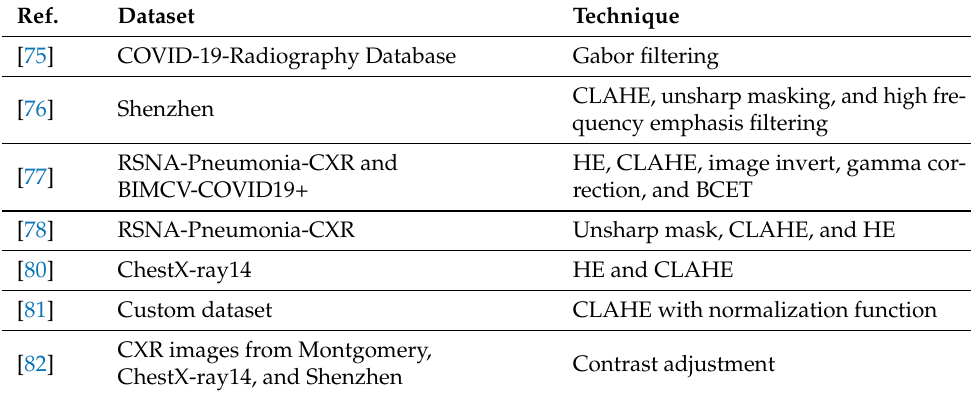
Table 4. Overview of different enhancement techniques for CXR images.